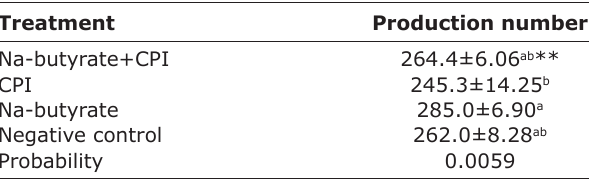
Table-3: Effect of Na-butyrate feed supplementation on production number of CPI and non-infected broilers. Treatment